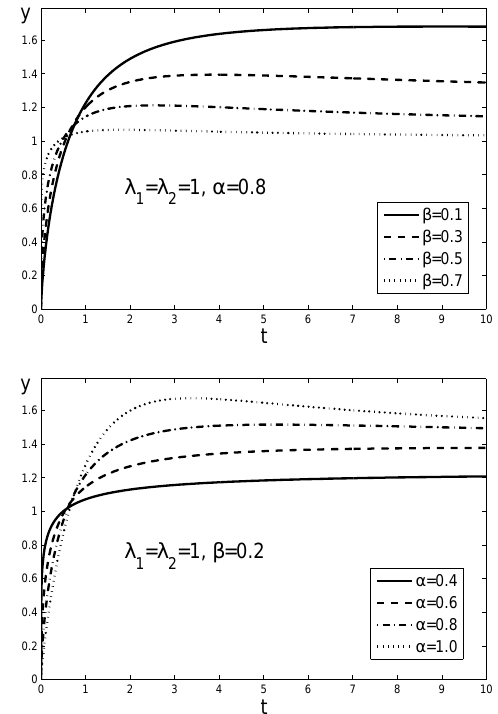
Fig. 4. Time profiles of the pressure gradient for α > β , A = 1 and λ 1 = λ 2 = 1